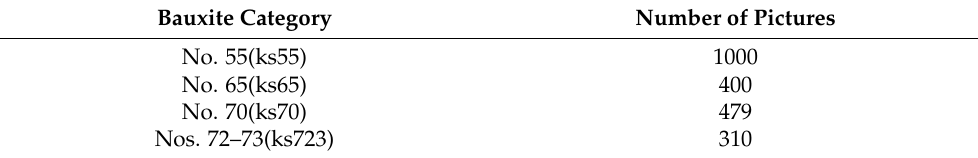
Table 1. Total data.